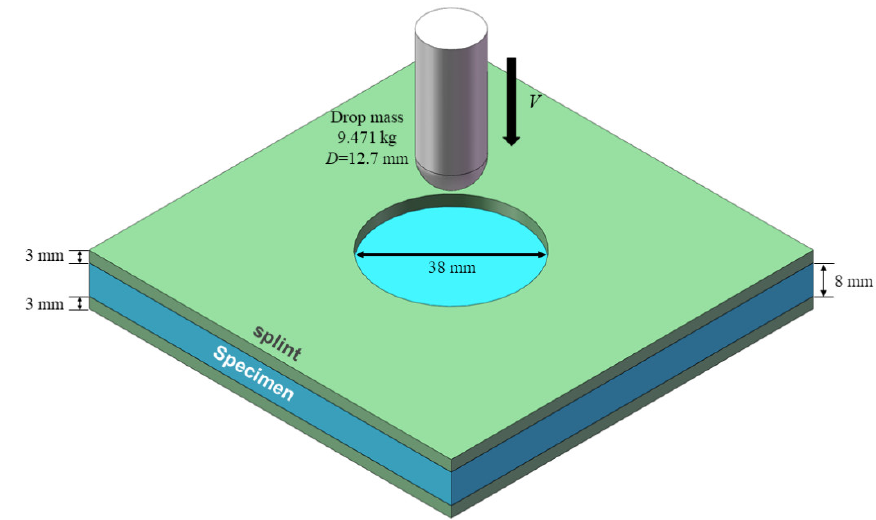
Figure 7. Schematic diagram of the drop tower test.